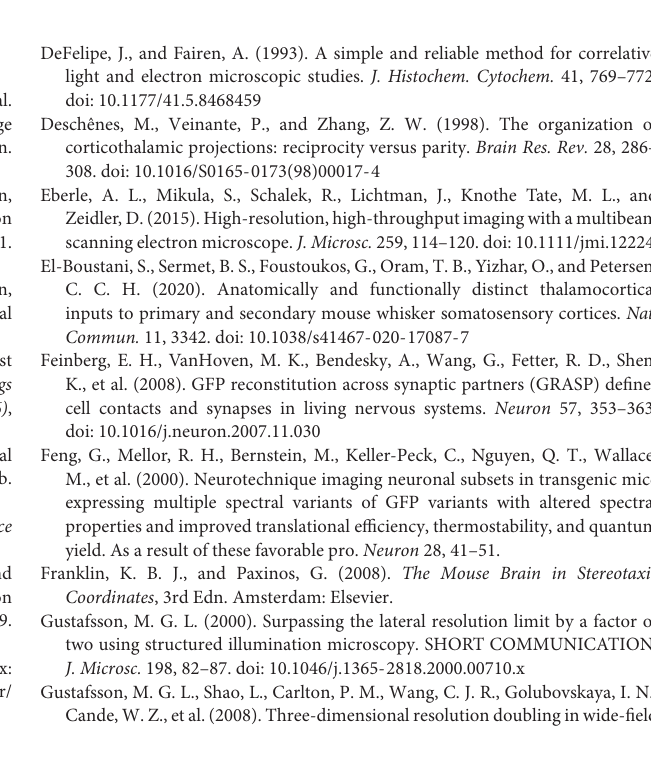
Supplementary Figure 1 | Spatial resolution of SIM images. (A) A relatively small pre- and postsynaptic structure image acquired by conventional microscopy (upper) and SIM (lower), and a zoomed-in view (white box, inset). Scale bars represent 10 µ m (left) and 1 µ m (inset). (B,C) Pixel intensity plots in the magnified images of conventional (dotted) and SIM (solid) images. Supplementary Figure 2 | Hit and false-negative synapse detection rate of SIM-PRIUS. Comparing of 20x conventional image and 100x SIM images on the same area and quantifying how well the physical connections observed with SIM can be detected in 20x images. Supplementary Figure 3 | Graphical user interface (GUI) for synapse validation. SIM image of the ROI can be visualized with custom-built graphical user interface (GUI) based on Java script (Supplementary Data 1). The GUI renders SIM image in series of the selected ROI with mouse scrolling ( (cid:172) ). The contrast of each channel can be adjusted by the setting minimum and maximum pixel values ( (cid:173) ). The color map, pixel values, and normalized pixel values of the selected line (vertical white line in the image panel) are visualized on the right-hand column of the GUI ( (cid:174) ). Each SIM image series of ROI was loaded with the GUI for users’ visual determination if the structure is a synapse (True), not a synapse (False) or ambiguous to determine (Fail) by clicking an appropriate button ( (cid:175) ). The three-dimensional coordinate of the true synapse is saved. Supplementary Data 1 | Code availability. All data supporting the findings of this study are provided in the main text. All the code is available